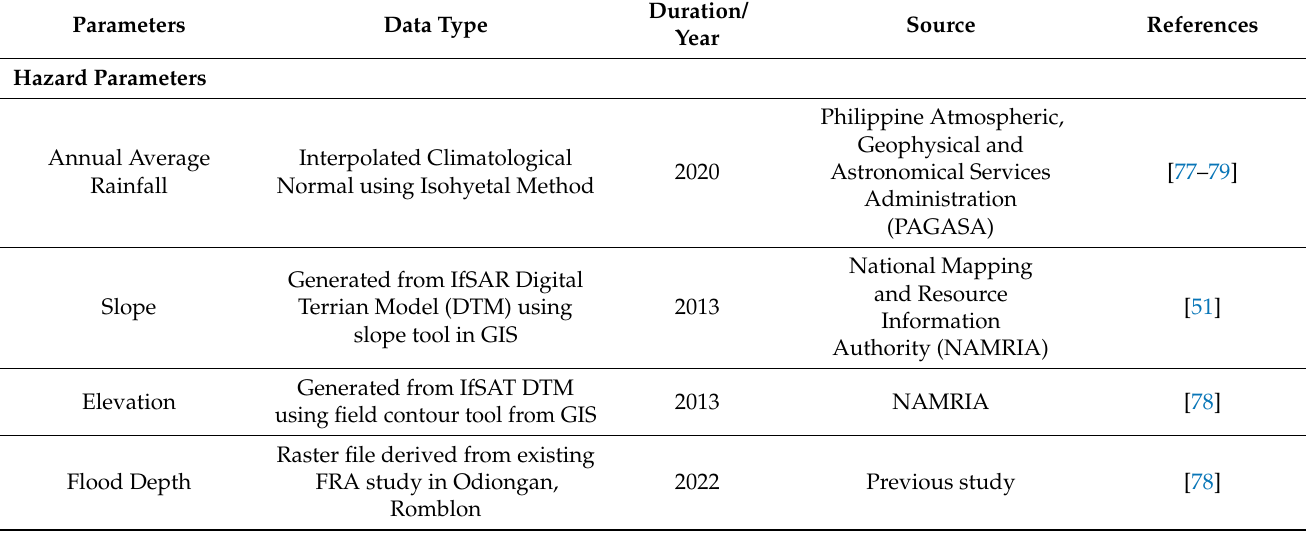
Table 2. Different parameters, data types, duration/year, and sources were used in the study.